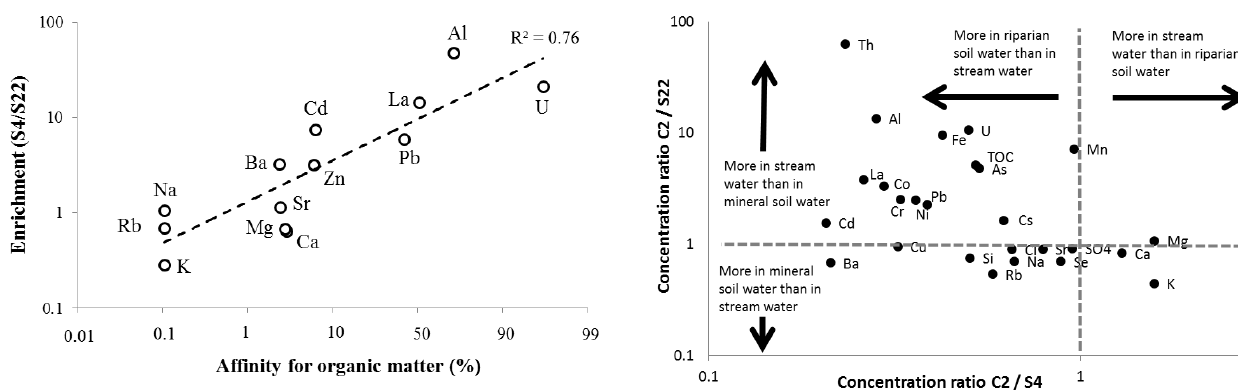
Figure 6. Ratios between the average concentrations in stream wa- ter (C2) and riparian soil water (S; horizontal axis) and between the average concentrations in stream water (C2) and mineral soil wa- ter (S22; vertical axis). Elements above the dashed horizontal line occur in higher concentrations in the stream water than in the min- eral soil water. Elements to the left of the vertical lines occur in higher concentrations in the riparian soil water than in the stream water. The selection of elements is based on the available measure- ments in this study and the stream water data presented by Lidman et al.